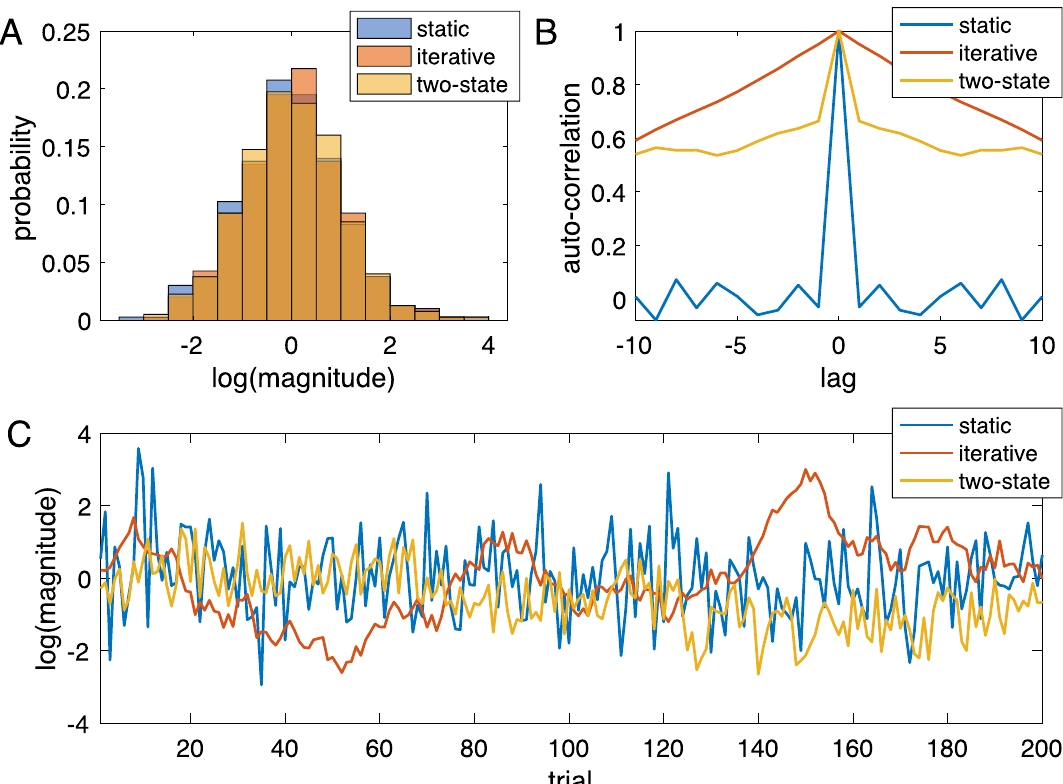
Figure 6. Sequences of stimuli (arbitrary range) generated by the three models. The sequences for the iterative and two-state model have been generated such that their histograms resemble that of the static sequence. ( A ) Histograms. The dark orange color results from overlapping bars of all three colors. ( B ) Autocorrelation. ( C ) First 200 samples of all three sequences. The variances of the two-state model were chosen so that the autocorrelation at lag 1 equals approx.